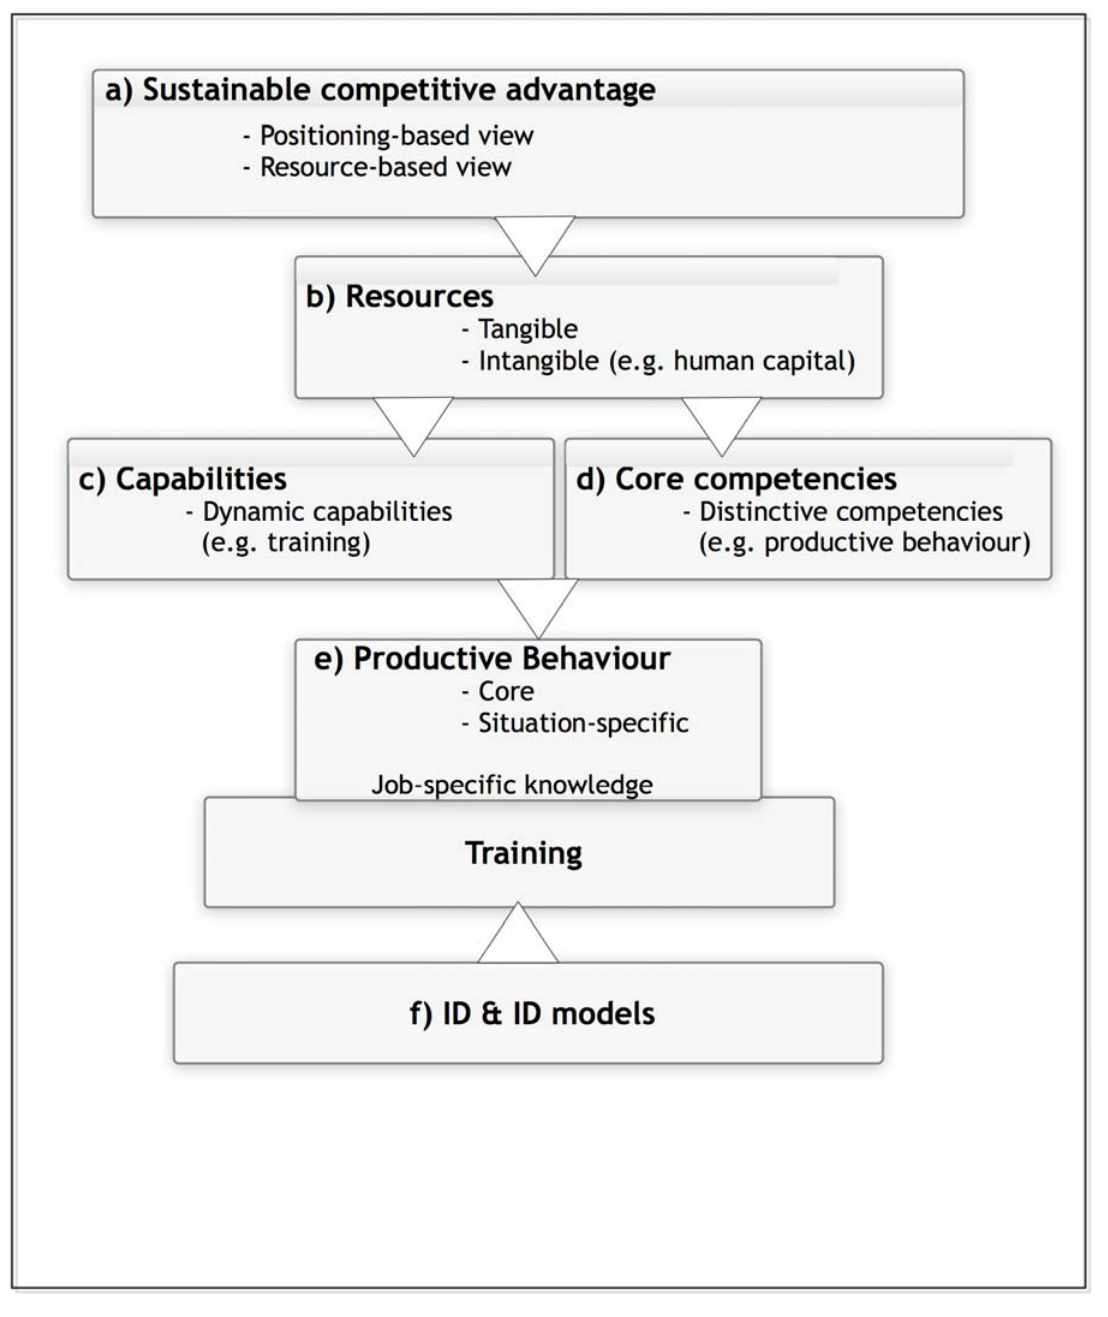
Figure 1: Theoretical frame of